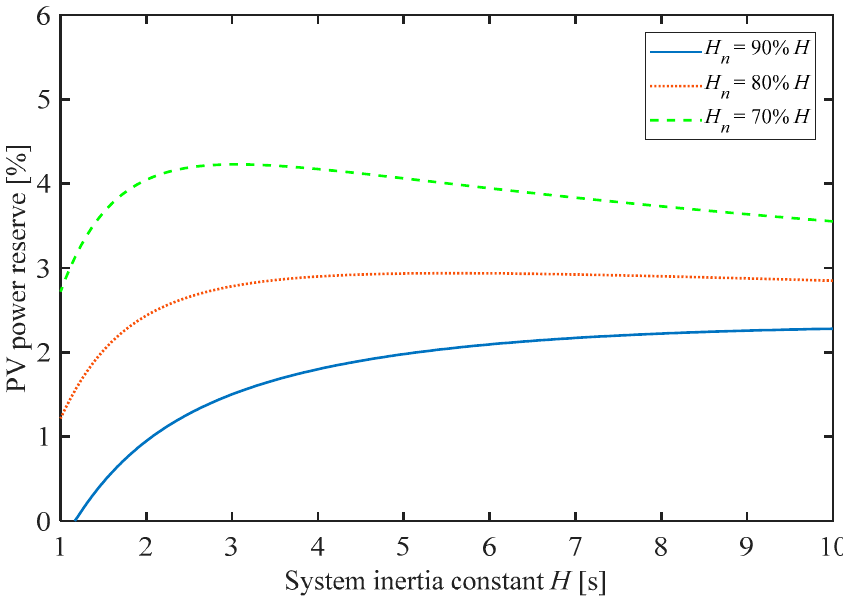
Figure 13. Required PV reserve minimum for Croatian EPS.